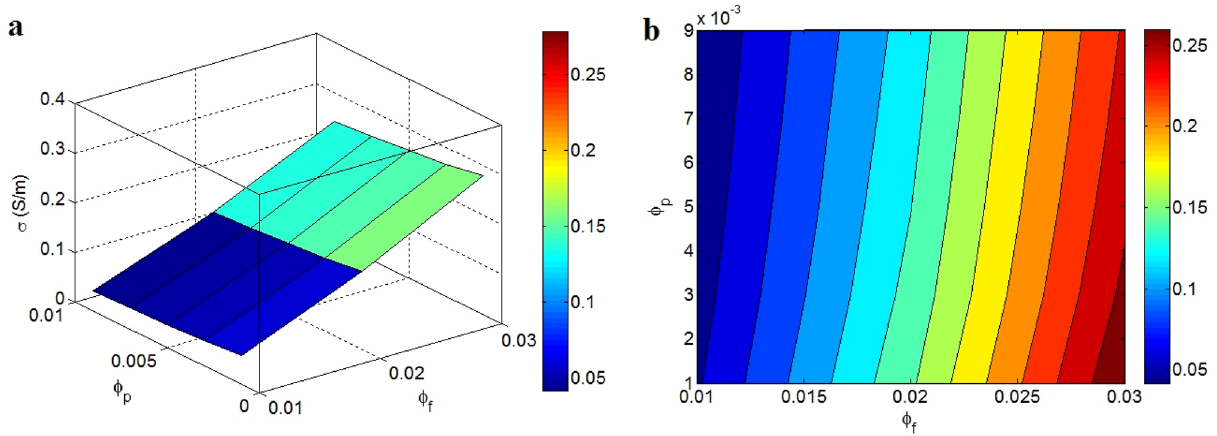
Figure 4. The predictions of novel model at various ranks of “ ϕ f ” and “ ϕ p ”: ( a ) 3D and ( b ) contour configurations.